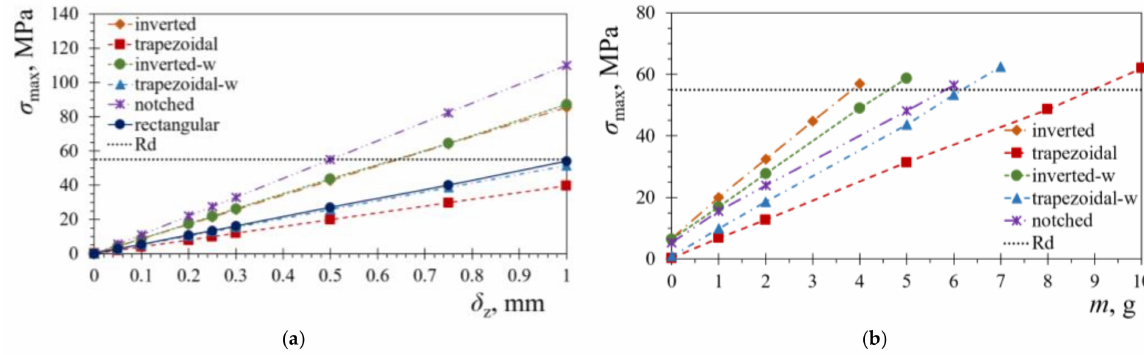
Figure 10. Piezoelectric material bending stresses of the considered PEH shapes: for various tip displacements δ z ( a ) and for various tip masses m ( b ) when the PEHs are subject to harmonic